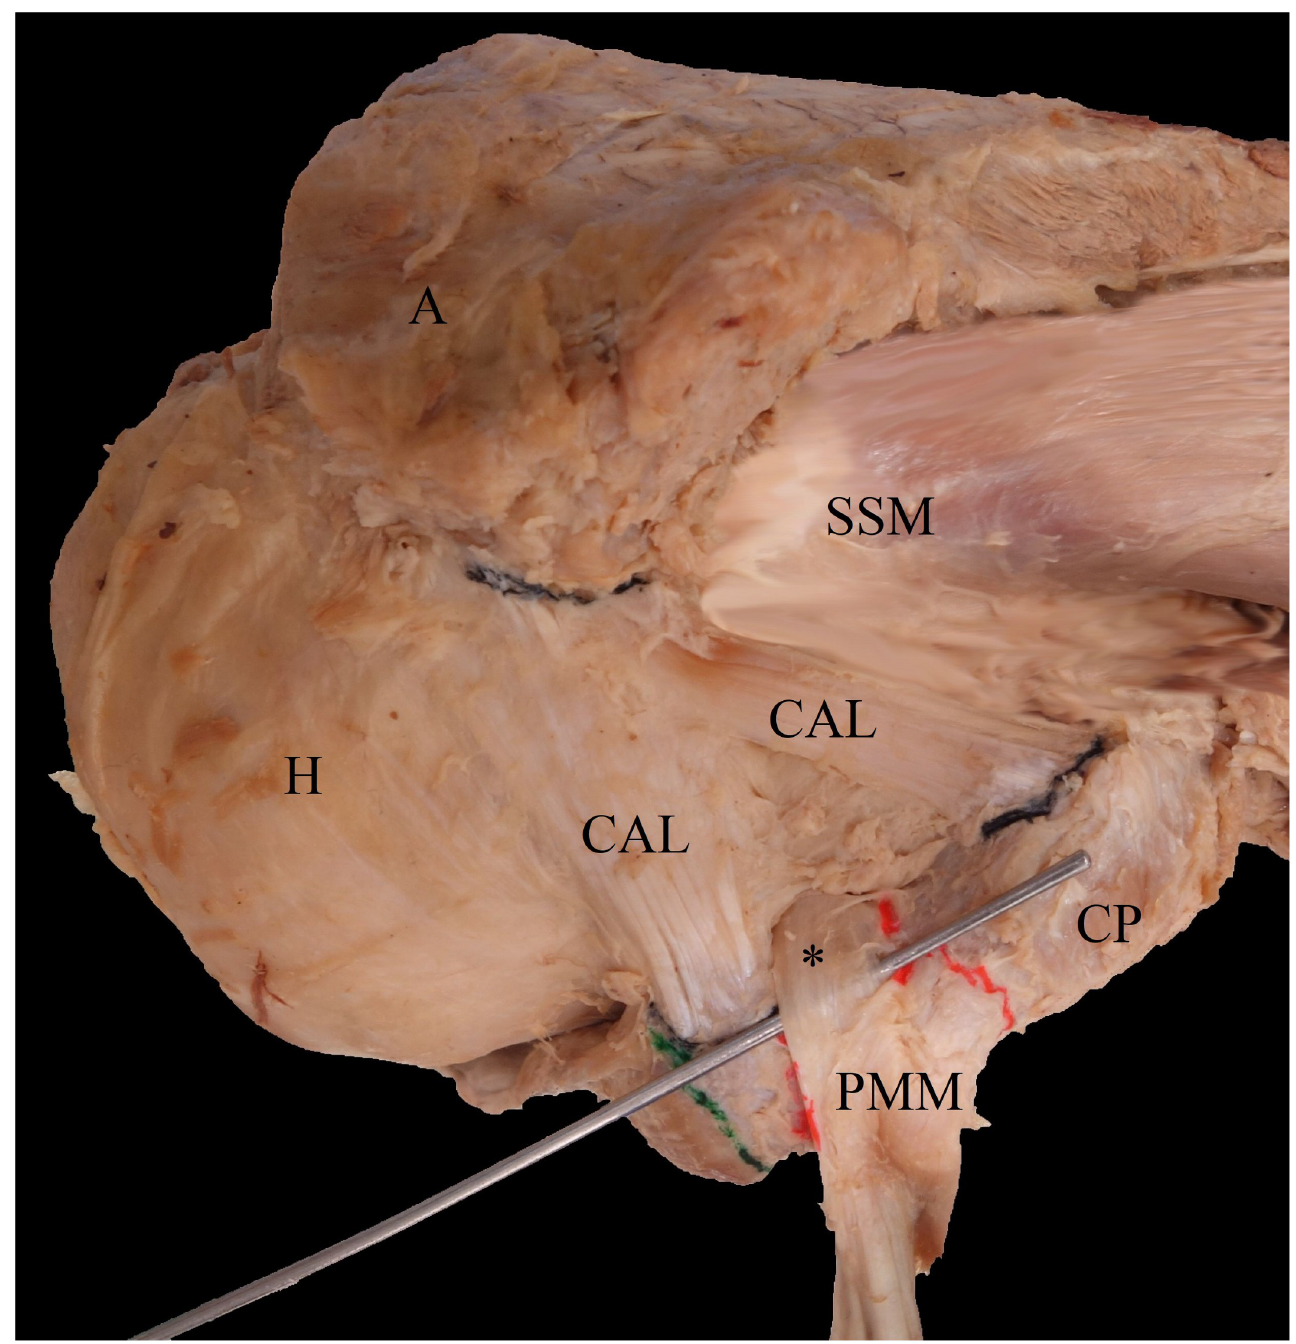
Fig 2. Exemplary photograph of a right shoulder seen from superior. The ectopic pectoralis minor tendon ( � ) runs over the coracoid process and through the branches of the coracoacromial ligament (CAL). A = acromion, CAL = coracoacromial ligament, CP = coracoid process, H = humerus, PMM = pectoralis minor